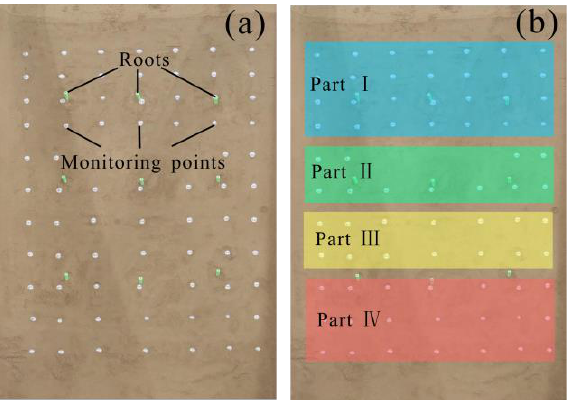
Figure 9. Control chart of slope surface displacement tracking points. ( a ) Layout of monitoring spots, ( b ) slope part division.